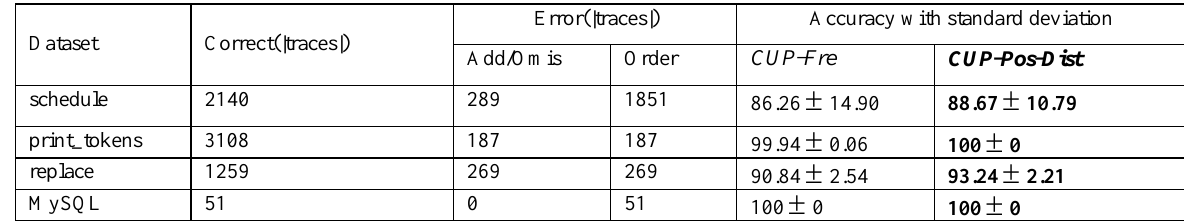
Table 7. Experiments 1: results on real-life datasets